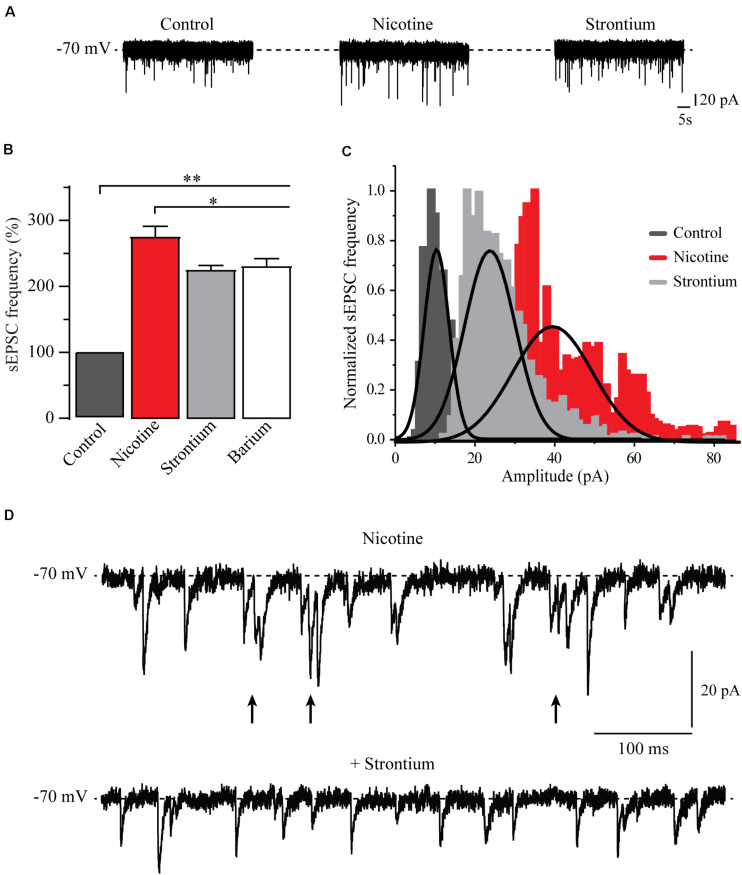
Nicotine synchronizes glutamate release. (A) Current traces showing sEPSCs in control condition (left), 10 min after the application of nicotine (middle), 10 min after replacing 90% of the extracellular calcium by strontium (right). (B) Bar graph of the sEPSC frequency that compares different conditions: control (dark gray) nicotine (red) strontium (light gray), and barium (white) (Mann–Whitney U-test). (C) Amplitude histograms for control (dark gray), nicotine (red), and strontium (light gray). (D) Current trace showing a typical sEPSC bursting evoked by nicotine (top). Note that the addition of strontium abolished the bursting and decreased the amplitude of sEPSCs (bottom). *p < 0.05, **p < 0.01.